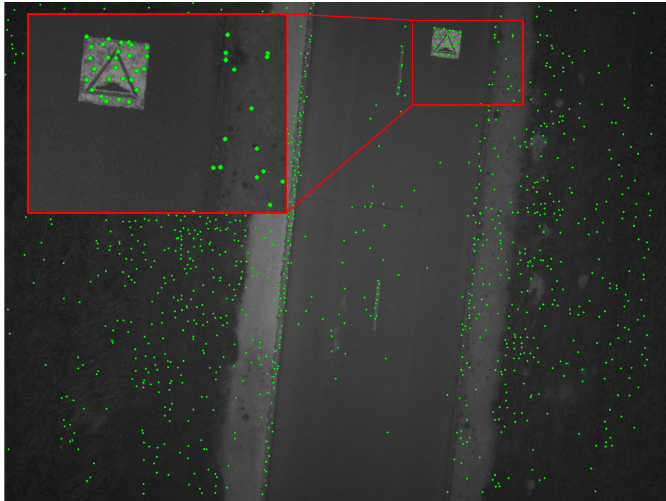
Figure 11. Feature points detected using the FAST algorithm in the first image; the threshold chosen here is 7. The number of grid blocks is defined as 100 × 100; image resolution: 2560 × 1920